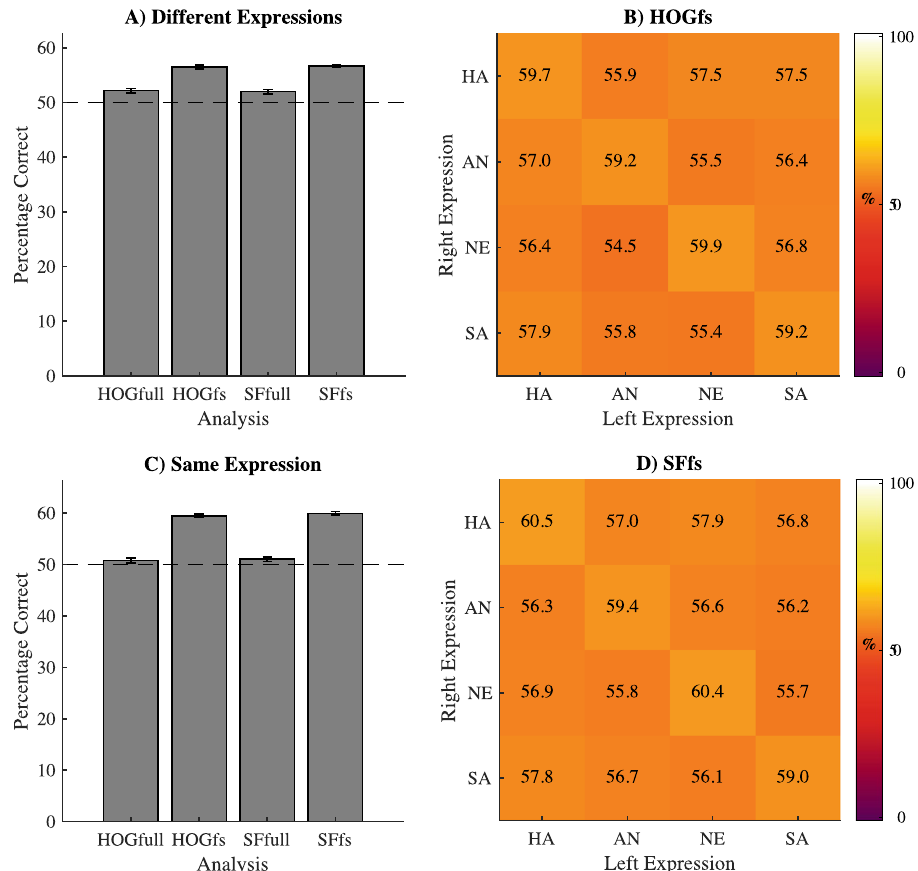
Figure 5. ( A ) The average decoding performance across participants (y-axis) for different modelling procedures (x-axis) based on the trials where different expressions were presented to the participants. ( C ) The same type of results but based on the trials where expressions have the same emotional content. The dotted lines represent the overall empirical chance level performance. Errorbars represent the standard error of the mean. ( B , D ) Confusion Matrices for the feature selection models. For all trials of each participant, we reorganized the decoding performance to show how well the model performed for combinations of expressions. Here, performance is represented as a matrix with expression of the right face on the y-axis and left face on the x-axis. Colour intensity reflects the fraction correct for the specific combination of expressions. Note that, performance is nearly equal for all combinations of expressions. Figures generated using Matlab 2019b ( www. mathw orks. com).